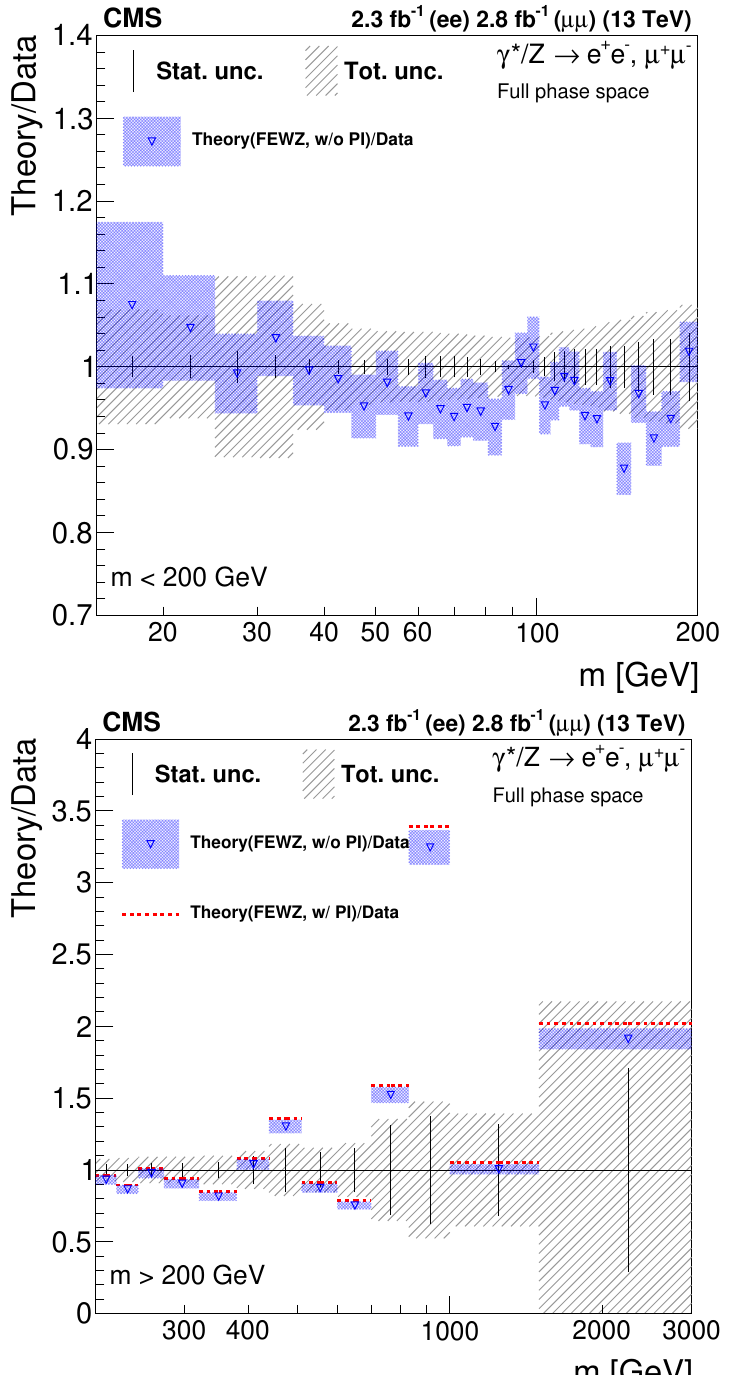
Figure 7 . Magni(cid:12)ed view of the ratio of the NNLO theoretical prediction of fewz with NNPDF 3.0 to data for the combined di(cid:11)erential cross sections in two di(cid:11)erent mass ranges: m < 200 GeV (top) and m > 200 GeV (bottom). The blue bands represent the theoretical uncertainty on the ratio. The bottom plot also shows the ratio with the photon-induced contribution (red dashed lines), which has a sizable e(cid:11)ect in the high-mass region.